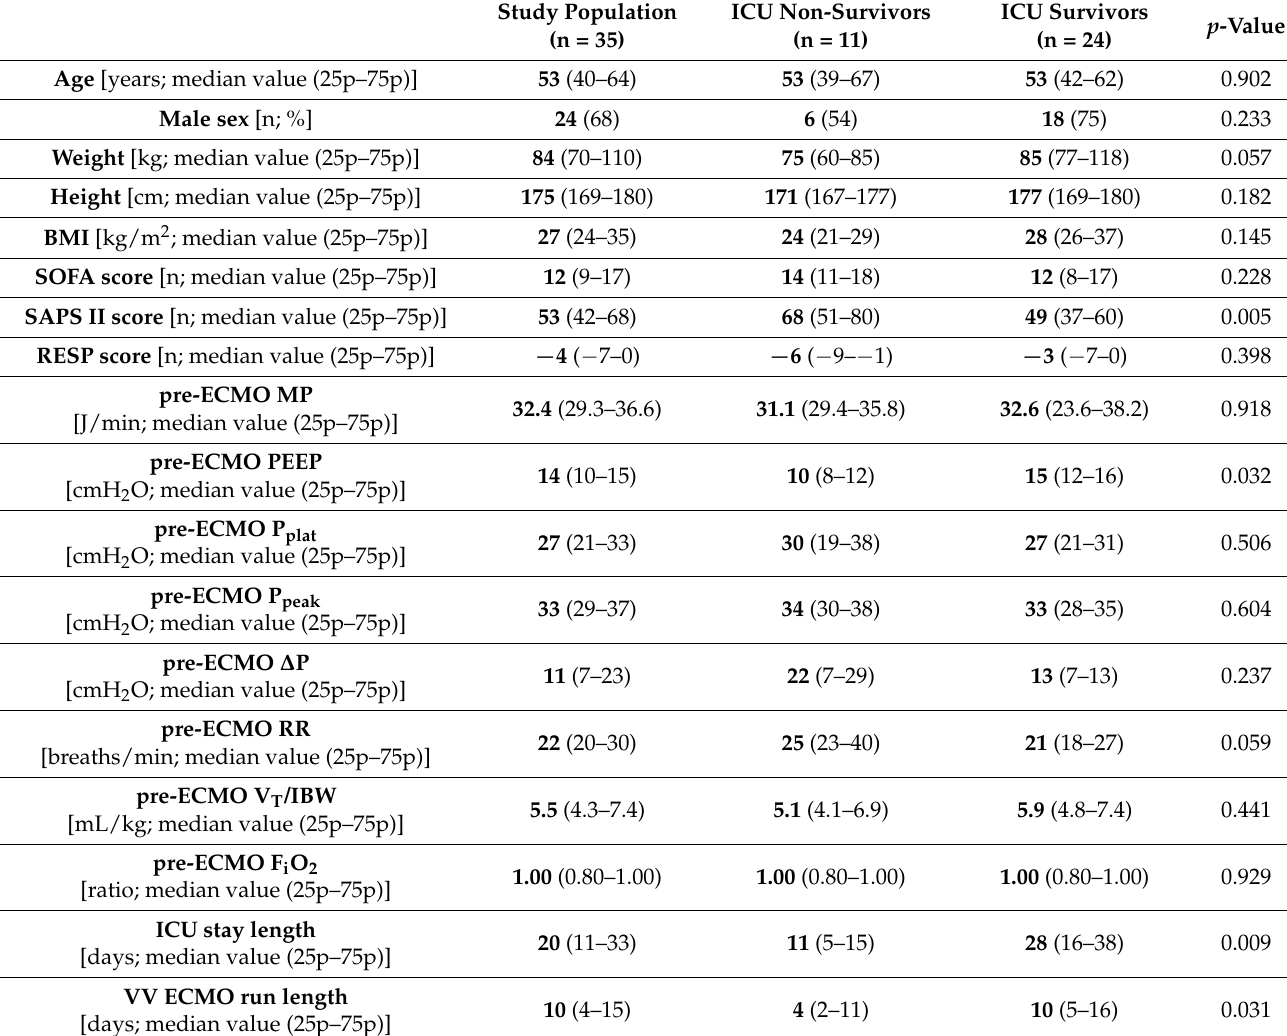
Table 1. Study population baseline demographic and anthropometric characteristics, ICU admission prognostic scores, MV settings before VV ECMO initiation (pre-ECMO), ICU stay and ECMO run length. Variables comparison according to ICU mortality. [ICU intensive care unit, MV mechanical ventilation, VV ECMO veno-venous extracorporeal membrane oxygenation, BMI body mass index, SOFA sequential organ failure assessment, SAPS simplified acute physiology